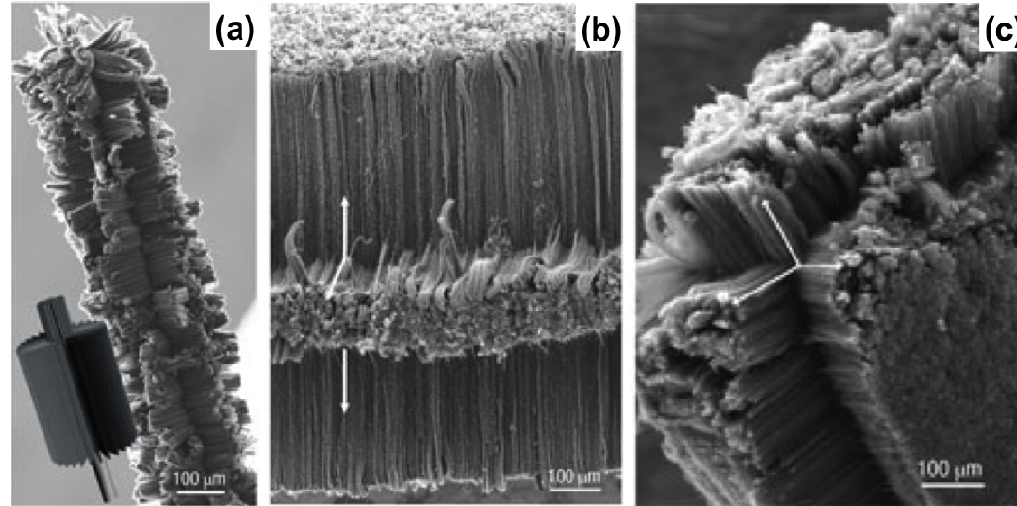
Figure 6. SEM of aligned MWNT arrays grown on metallic substrate showing growth directions conformal to the substrate orientation. Growth of carbon nanotubes on ( a ) metal wire, ( b , c ) metal sheets showing the highly directional nature of the CNT growth, with the orientation of the nanotubes being perpendicular to the substrate surface. The arrows indicate the direction of CNT growth